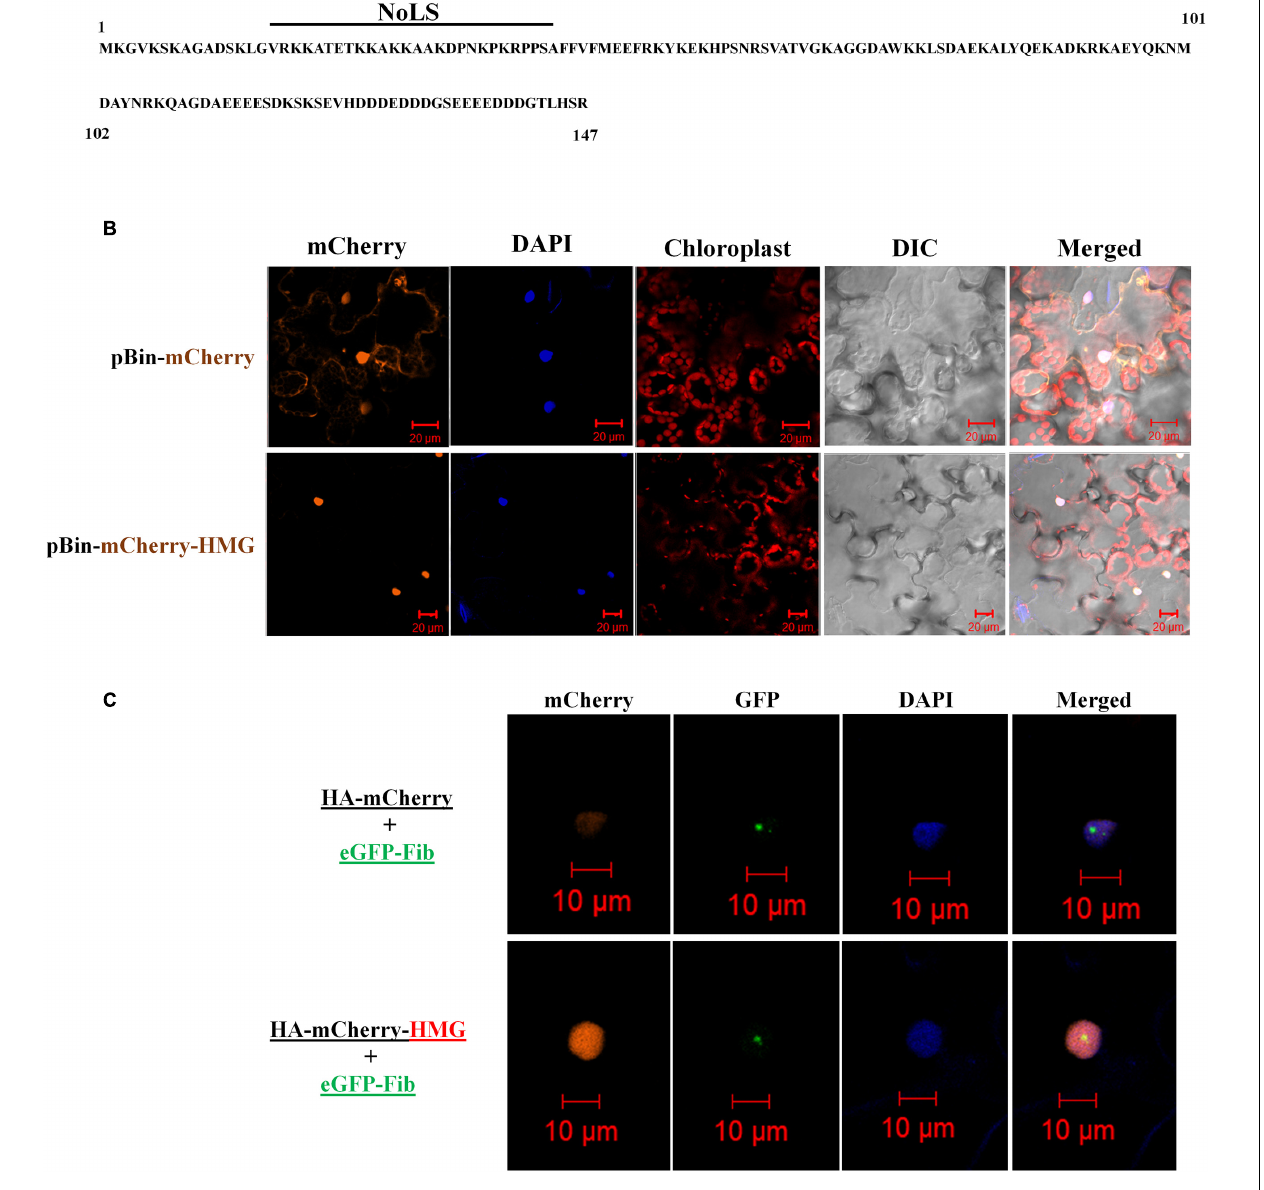
FIGURE 2 | Domain analysis and localization of NbHMG1/2a. (A) Predicted domains encoded in NbHMG1/2a: a nuclear localization signal (NLS) between 4 and 56 amino acids (aa), a nucleolar localization signal (NoLS) between 15 and 42 aa, and a DNA-binding domain between 36 and 101 aa. No nuclear export signal was found. (B) NbHMG1/2a localizes in the nucleus. N. benthamina leaves were infiltrated with Agrobacterium carrying pBin61-HA-HMG-mCherry or with control vector pBin61-HA-mCherry. (C) NbHMG1/2a localizes in the nucleolus. N. benthamina leaves were infiltrated with Agrobacterium carrying HA-mCherry and nucleolus-localized fibrillarin fused with eGFP (eGFP-Fib), or with HA-mCherry-HMG and eGFP-Fib. DAPI was used for nuclear staining. Images were taken 3 days after infiltration, and bars represent a measurement scale of 20 and 10 µ m for the nucleus and nucleolus, respectively. The experiment was repeated three times with similar results and representative images are